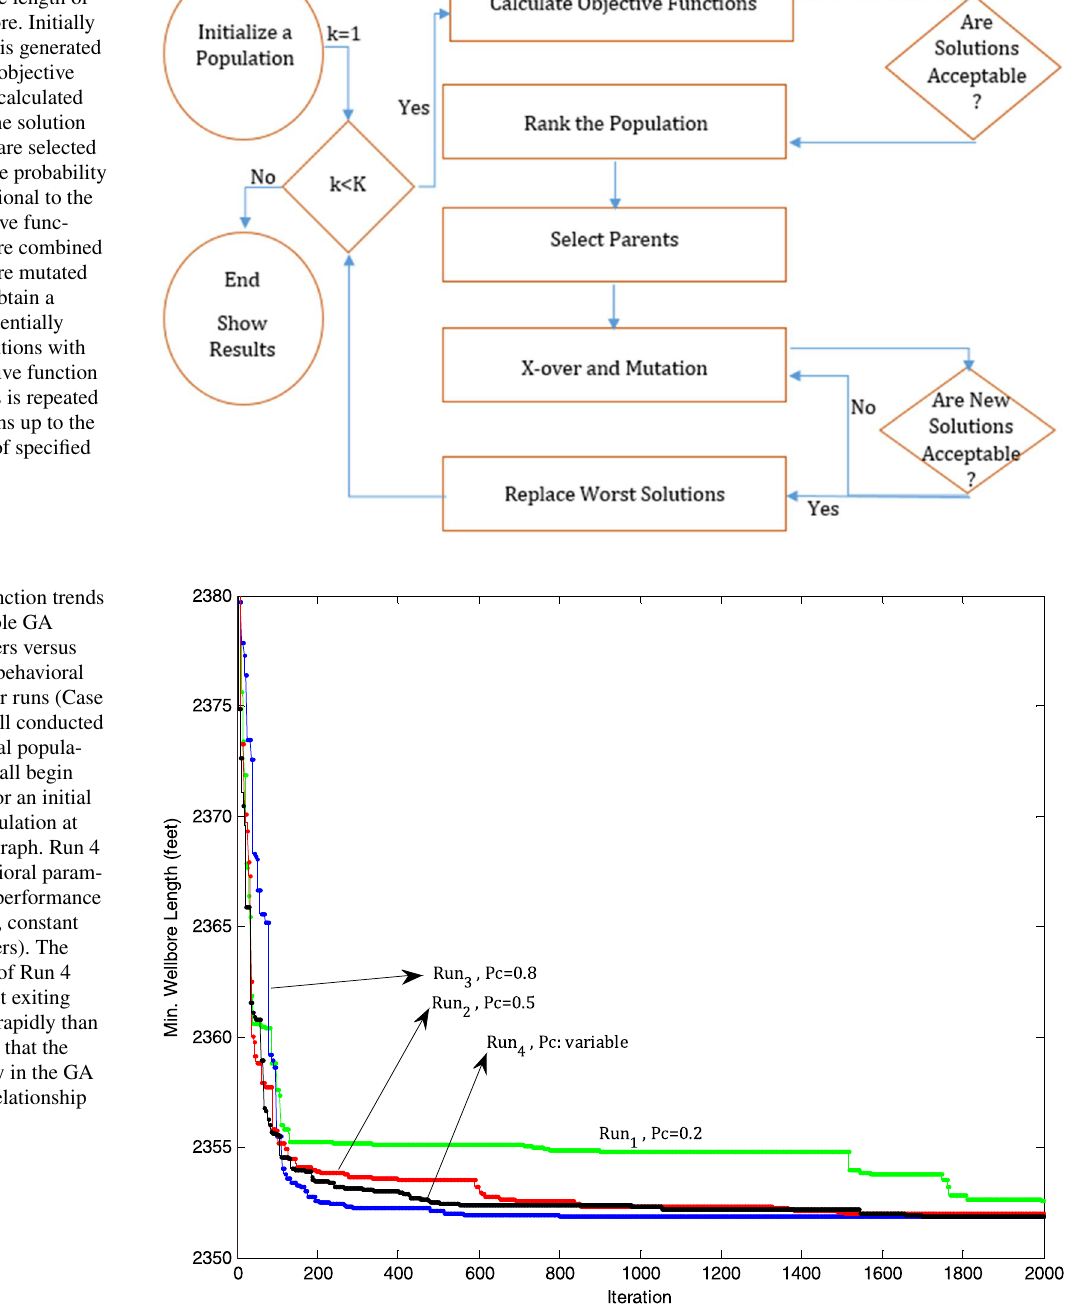
Fig. 5 Flowchart of GA used for optimizing well bore length of the example well bore. Initially a set of N solutions is generated randomly and their objective function values are calculated and ranked. From the solution set, some solutions are selected as “parents” with the probability of selection proportional to the rank of their objective func- tions. The parents are combined and some of them are mutated or crossed over to obtain a new solution set potentially involving some solutions with better fitness/objective function values. This process is repeated for multiple iterations up to the maximum number of specified iterations